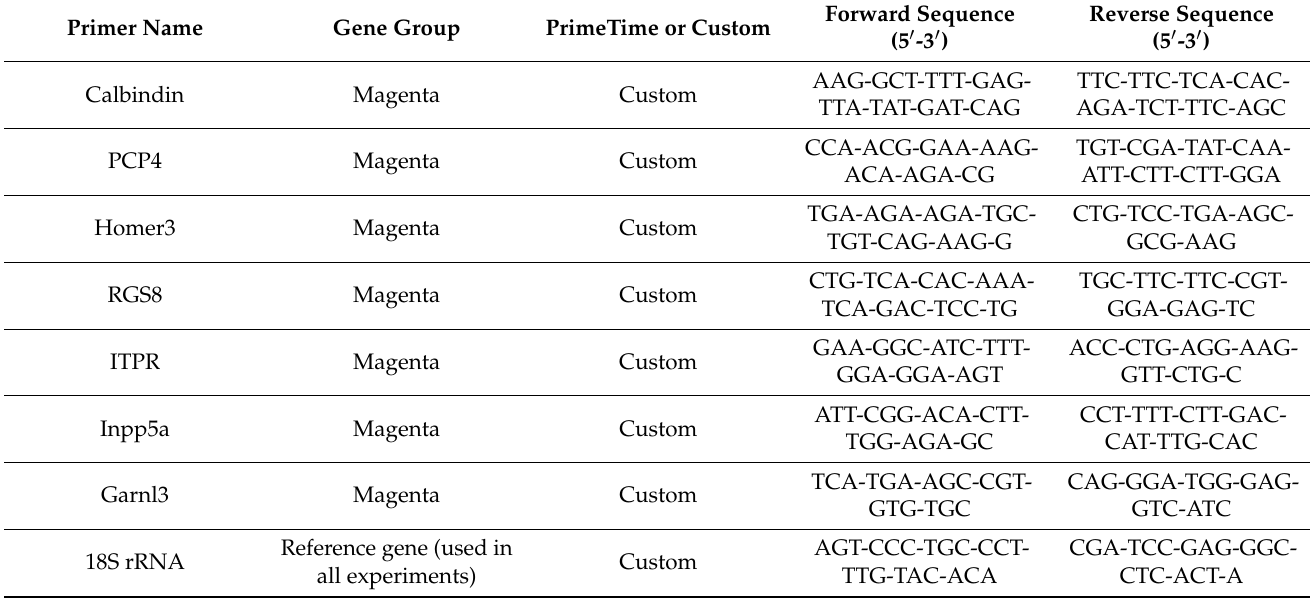
Table 1. Primers used for RT-qPCR. Table details the gene group for each primer, type of primer (PrimeTime or custom), and sequence (forward and reverse where